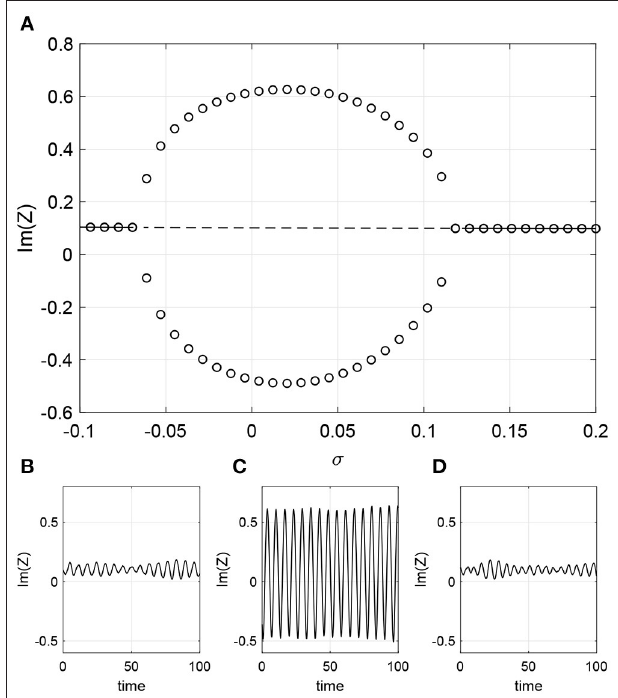
σ ˆ k in . (A) Solid line: FIGURE 9 | Intrinsic frequency dependence ω 0 ( k in ) 1 = + stable fixed point of Equation (40); dashed line: unstable fixed point. Circles: maximum and minimum over one period of Im( Z ). Im( Z ) calculated using (30) for (B) σ 0.1, (C) σ 0, and (D) σ 0.2. Other parameters: = − = = 1 0.05, β 0, ǫ 0.2, m 100, M 400, N = = = = = =